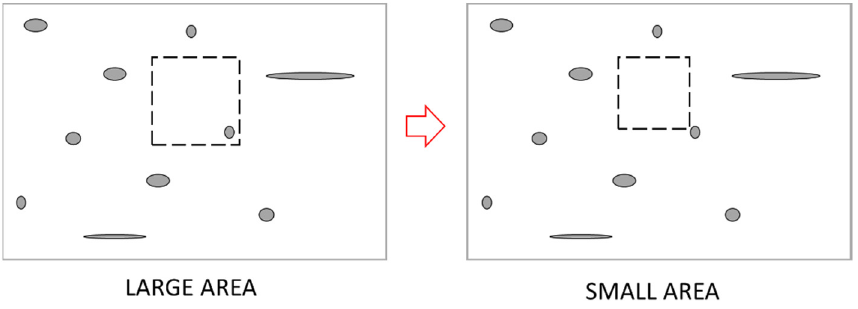
Figure 8. Schematic description showing the influence of edge effects on samples with a reduced value of the K3 index.